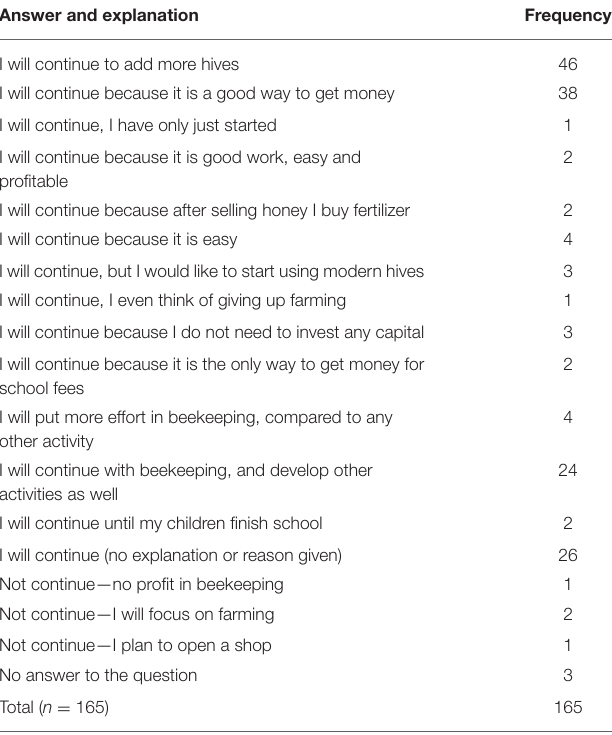
TABLE 8 | Explanations given by beekeepers about their beekeeping